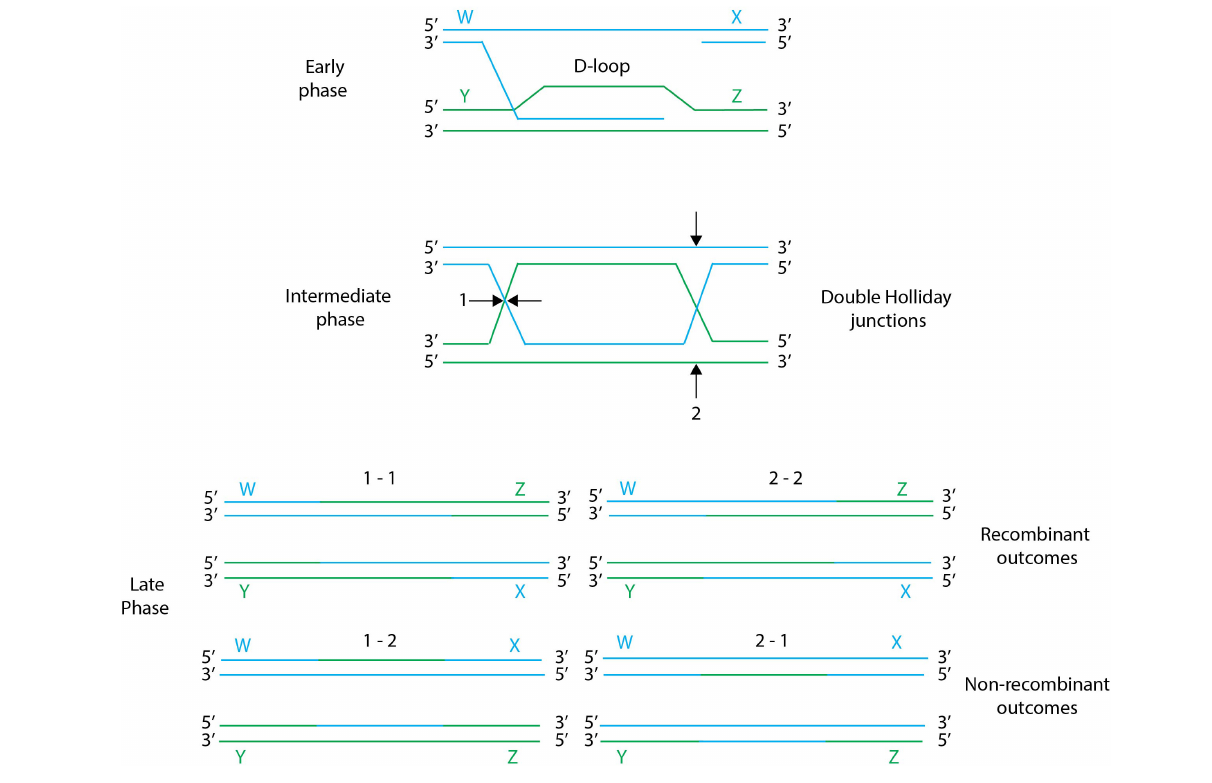
FIGURE 2 | General scheme of homologous recombination. Early, intermediate and late phases of homologous recombination: in the early phase the ssDNA arm from a nicked chromosome invades a homologous chromosome forming a D-loop, the resulting branched DNA leads to the formation of a double Holliday Junction intermediate. Holliday junctions can be resolved during the late phase by two types of resolution cuts, designated 1 and 2, resulting in different recombination outcomes. Resolution of Holliday junctions by the same cuts (i.e., 1–1 or 2–2) results in recombinants molecules, while resolution of Holliday junctions by the different cuts (i.e., 1–2 or 2–1) results in wild-type molecules with parental shoulders. Figure adapted from Kuzminov